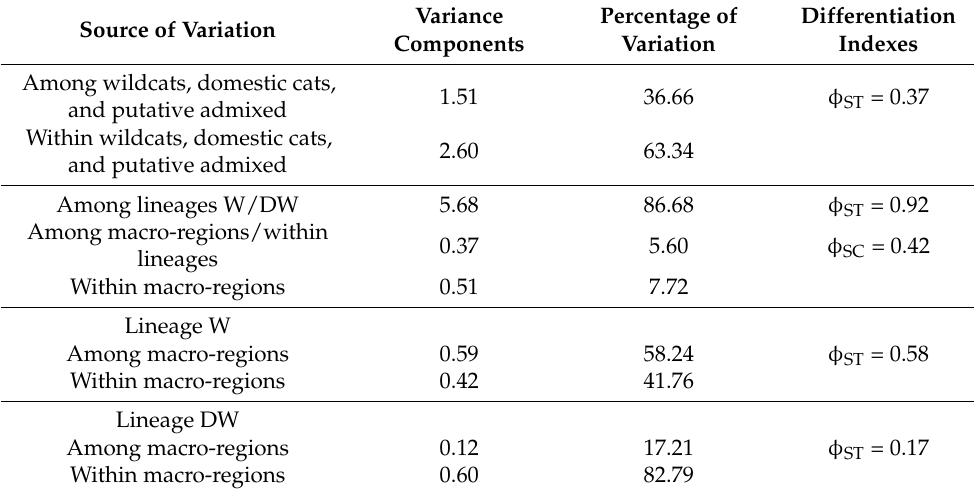
Table 2. Analysis of molecular variance (AMOVA) on a portion of the mitochondrial ND5 gene computed among and within three different sample groups: (a) the STR Bayesian assignment populations [25]; (b) the main phylogenetic lineages; and (c) the biogeographic macro-regions within each phylogenetic lineage. φ ST : differences among groups; φ SC : differences among populations within a group. All values were highly significant ( p < 0.05). Lineage DW represents lineage D pruned by domestic